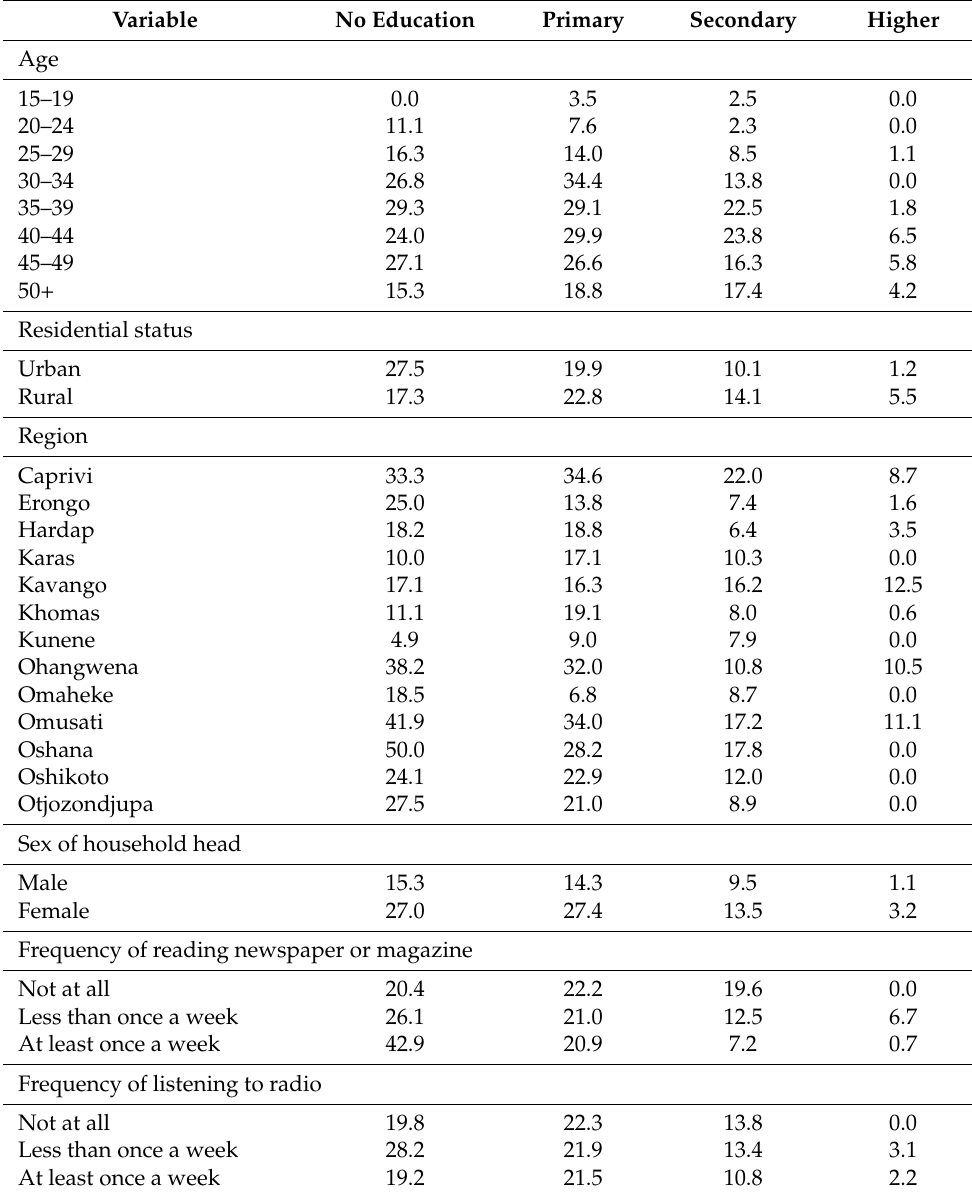
Table 4. Distribution of HIV prevalence by educational status across women’s characteristics in